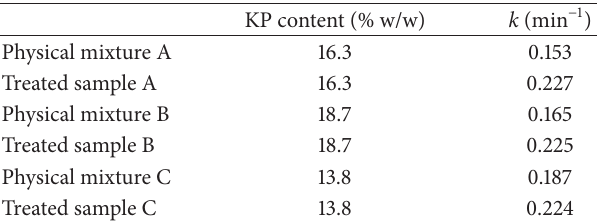
Table 3: Values of the 𝑘 parameter obtained from the fitting of the release profiles of tablets to